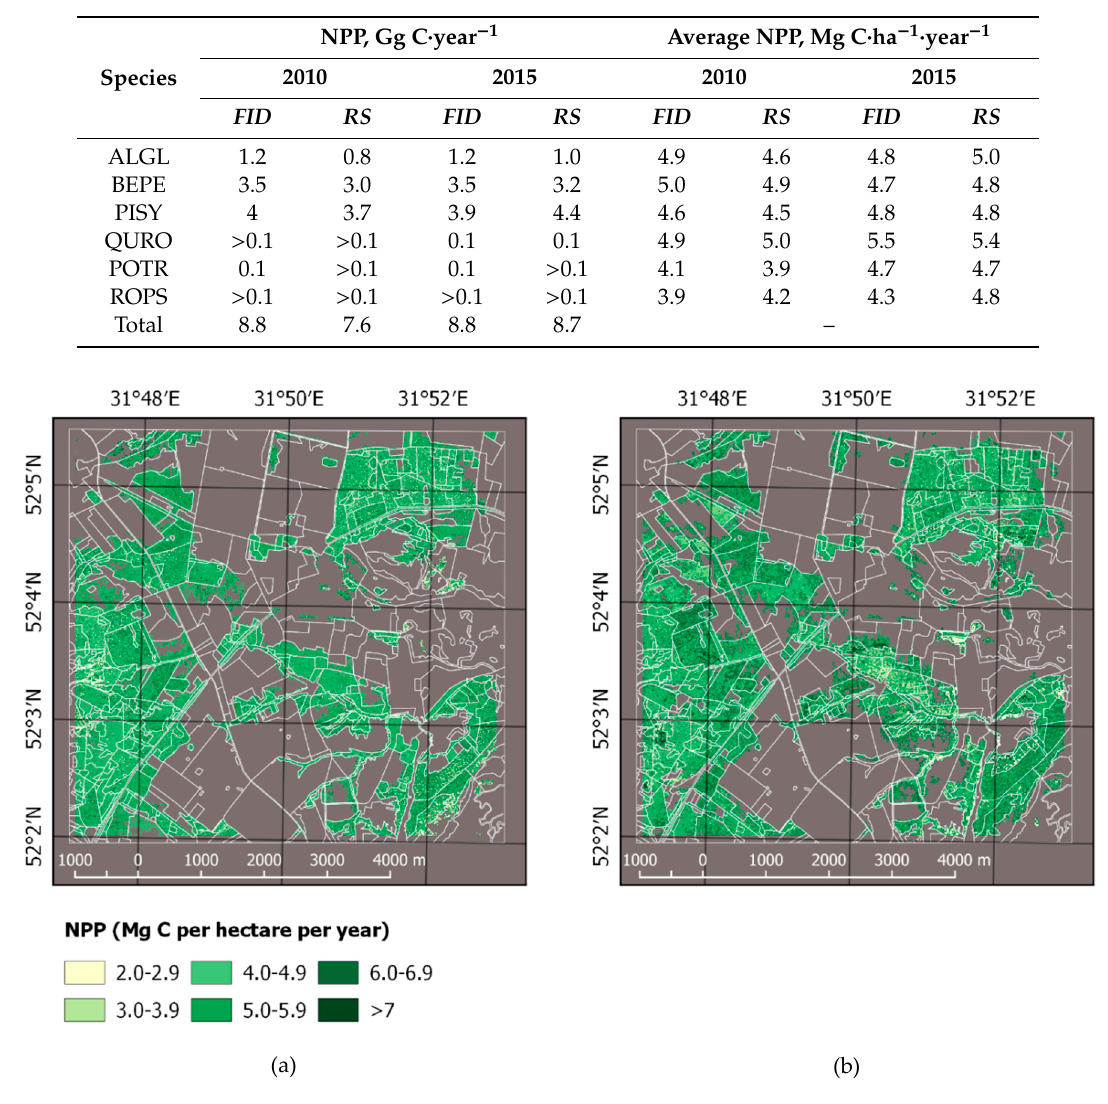
Figure 4. Net primary production (NPP) of forest ecosystems predicted by k -Nearest Neighbors method using satellite images: ( a ) RapidEye image for 2010; ( b ) SPOT 6 image for 2015.